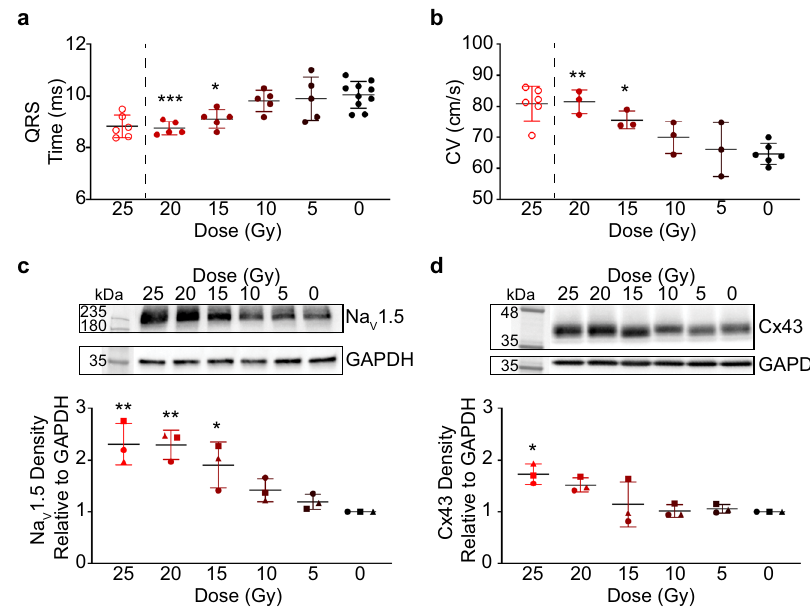
Fig. 3 Conduction velocity reprogramming may be achieved at lower doses of radiation. a Dose-dependent effects of radiation on QRS interval at 6 weeks post-IR ( n = 5 biologically independent animals per IR condition; n = 10 biologically independent 0 Gy control animals; *** P = 0.0009, 20 versus 0 Gy; * P = 0.023, 15 versus 0 Gy). b Dose-dependent effects of radiation on longitudinal conduction velocity ( n = 3 biologically independent animals per IR condition; n = 6 biologically independent 0 Gy control animals; ** P = 0.0023, 20 versus 0 Gy; * P = 0.046, 15 versus 0 Gy). c Dose-dependent effects of radiation on Na V 1.5 protein levels by western blot ( n = 3 biologically independent sample per condition over 3 independent experiments; ** P = 0.0014, 25 versus 0 Gy; ** P = 0.0016, 20 versus 0 Gy; * P = 0.023, 15 versus 0 Gy;). d Dose-dependent effects of radiation on Cx43 protein levels by western blot ( n = 3 biologically independent per condition over 3 independent experiments; * P = 0.011, 15 versus 0 Gy). Values plotted from western blots were obtained from three independent western blots each denoted by a closed square, circle, and triangle. Twenty- fi ve Gy QRS interval and CV values from Fig. 3 are plotted for reference (open circles) and are not used in statistical comparisons. Statistical analysis of all subpanels consisted of a one-way ANOVA followed by one-sided Tukey post hoc test of multiple comparisons. All bar graphs are represented as mean ± SD. Source data are provided as a Source data fi